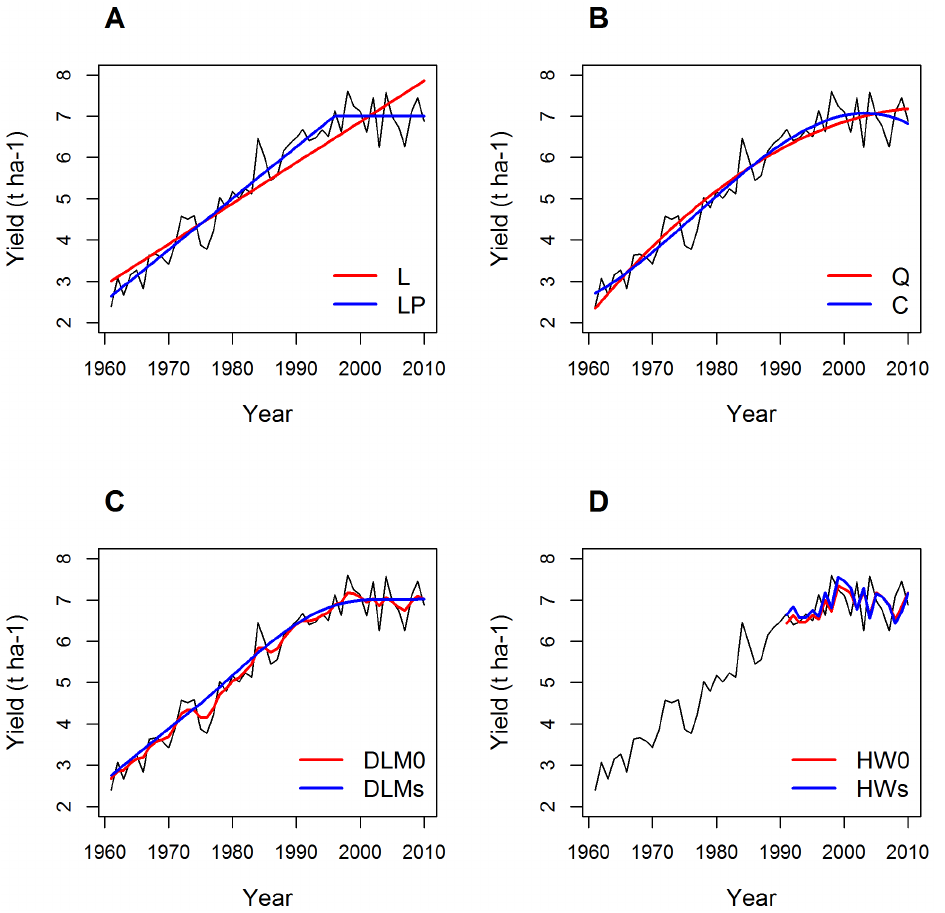
Figure 1. Wheat yield time series in France and fitted values obtained with different models. A: linear (L) and linear-plus-plateau (LP) models. B: Quadratic (Q) and cubic (C) models. C: dynamic linear models with and without trend (DLMs, DLM0). D: Holt-Winters models with and without trend (HWs, HW0).